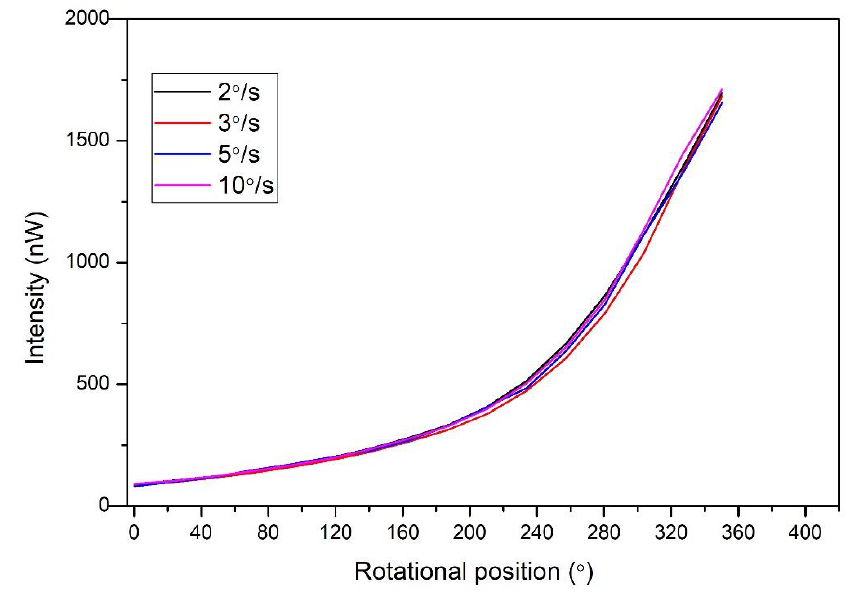
Figure 8. Dynamic response of the rotational sensor.